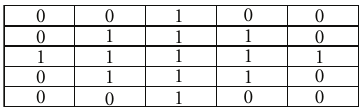
Figure 6: Structuring element in morphological